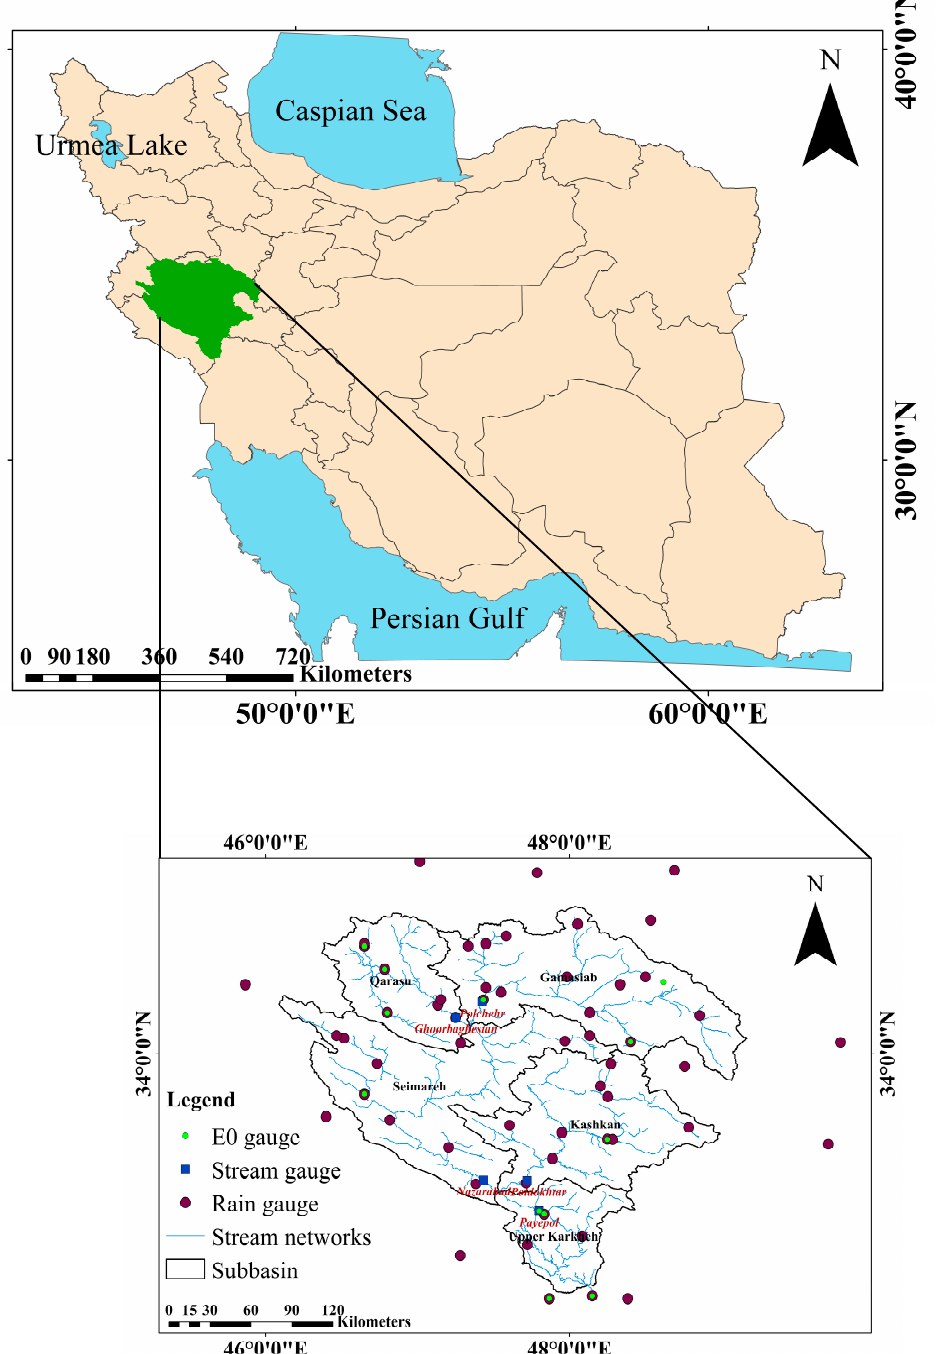
Figure 1. Location of the Karkheh River basin in Iran. E0 denotes potential evapotranspiration. The altitude of the basin varies from less than 10 m in the South to more than 3500 m above mean sea level in the North. Mean annual precipitation ranges from 150 mm in the south to 750 mm in the northern region (see Table 1). The maximum summer temperature varies between 35 and 45 ◦ C across the basin. Range and pasture, rainfed agriculture, forest, irrigated agriculture, and urban area are the dominant land uses